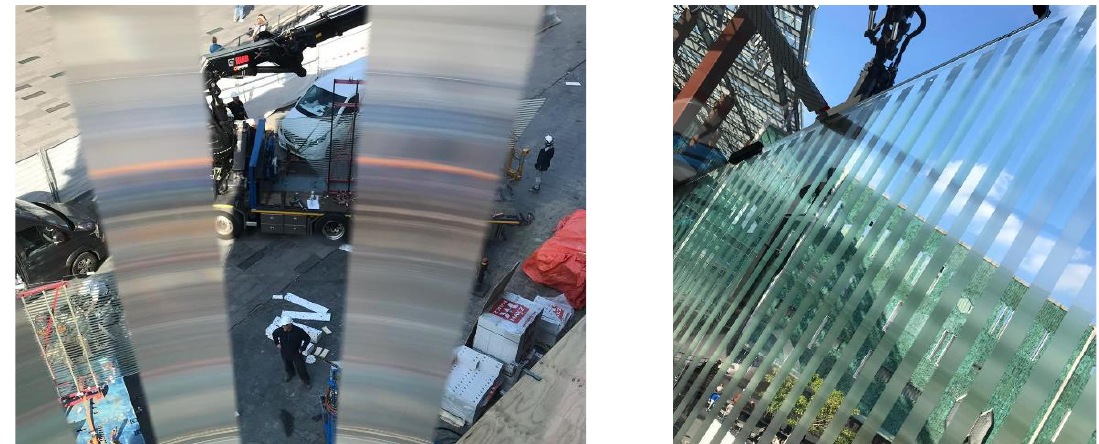
Fig. 12 reflecting film on the inside of the glass